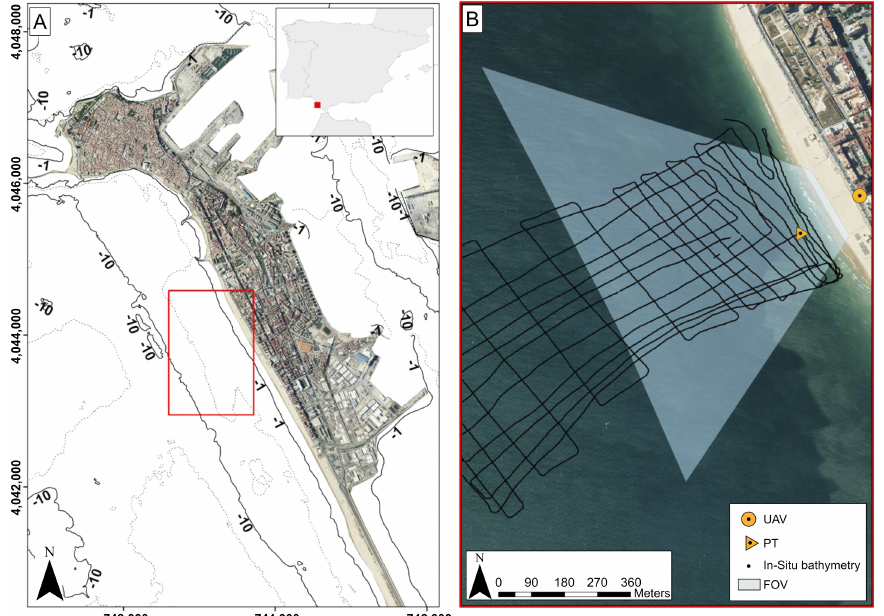
Figure 1. Regional map of Cádiz highlighting, with a red box, the study area of Victoria Beach ( A ); aerial image of Victoria Beach, showing the position of the drone (UAV) and corresponding (approximate) field of view (FOV), the pressure transducer position (PT), and the in situ echo-sounder track ( B